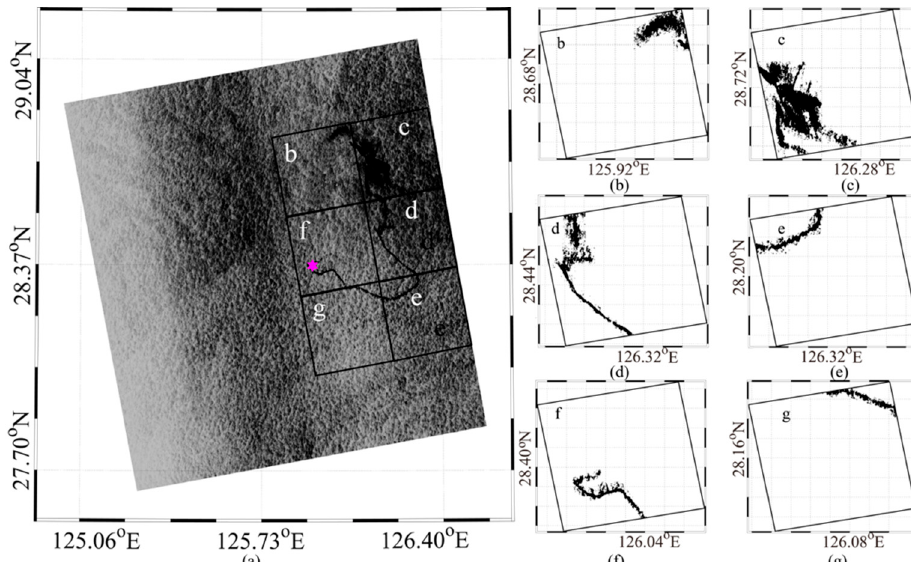
Figure 8. ( a ) The GF-3 SAR image on 15 January 2018 at 21:39, in which the pinkish marks represent the shipwreck position, and the sub-scenes b and c are used to extract spilled oil slicks; ( b ) The results of extracted oil slicks from sub-scene b, which are marked by black spots; and ( c ) The results of extracted oil-slicks from sub-scene c.